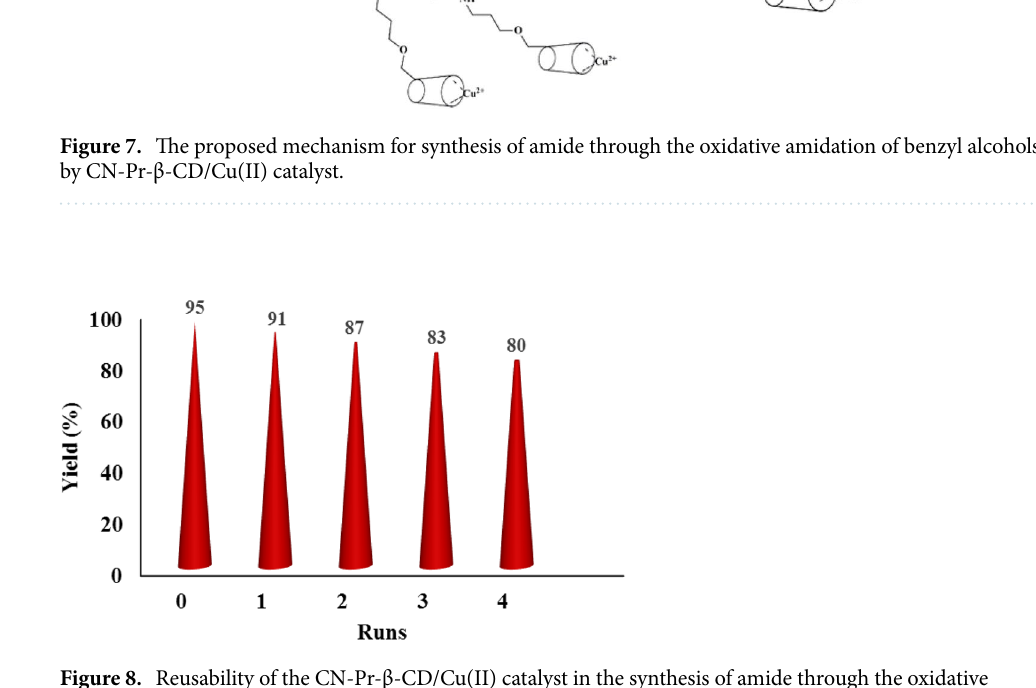
Figure 8. Reusability of the CN-Pr-β-CD/Cu(II) catalyst in the synthesis of amide through the oxidative amidation of benzyl